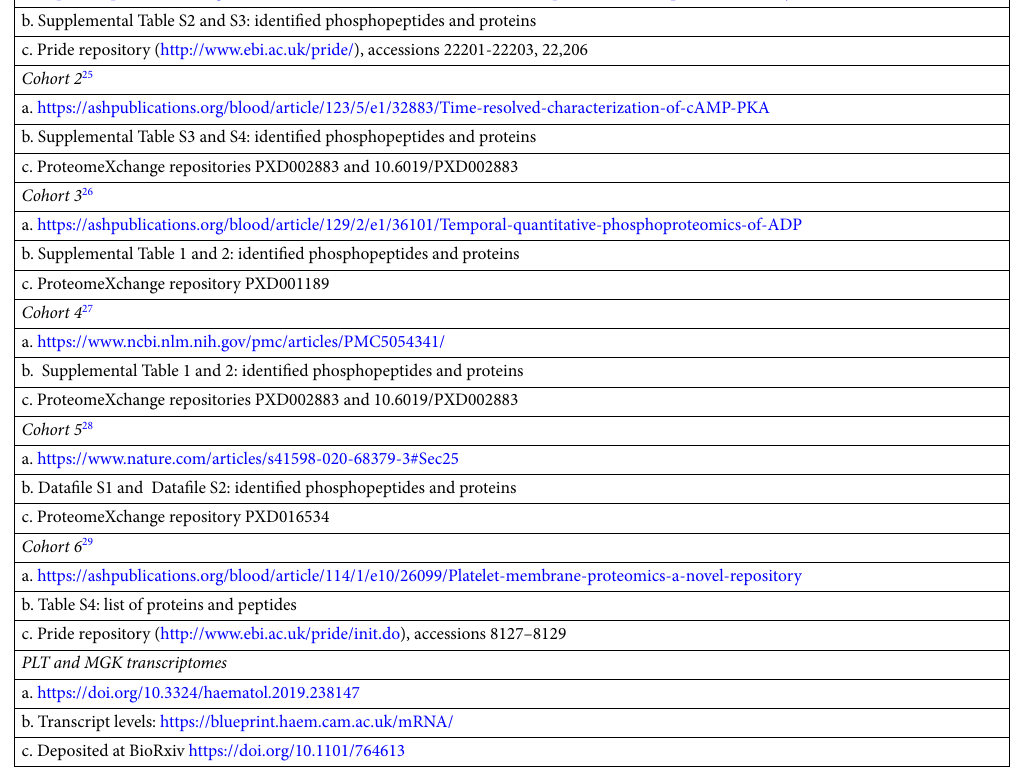
Table 1. Accessibility per proteome cohort of website link (a), used raw datasets (b) and deposited spectral data (c).